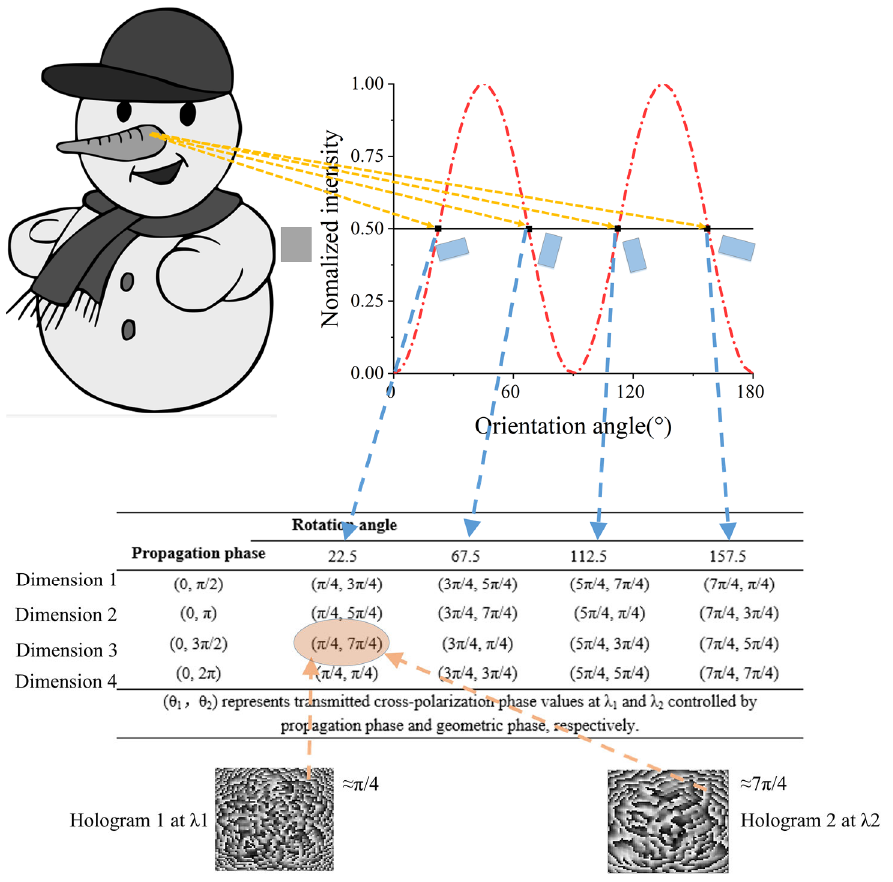
Figure 4. Principle schematic of the three ‐ channel metasurfaces for multi ‐ wavelength holography and nanoprinting .